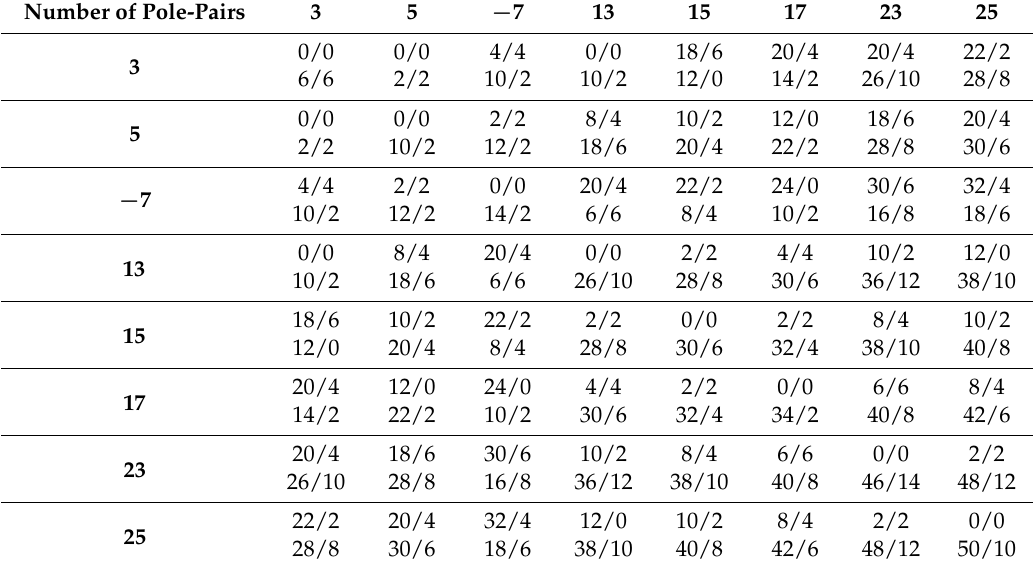
Table 3. The radial electromagnetic force in the air gap produced by the permanent magnetic field (mode number/frequency times).